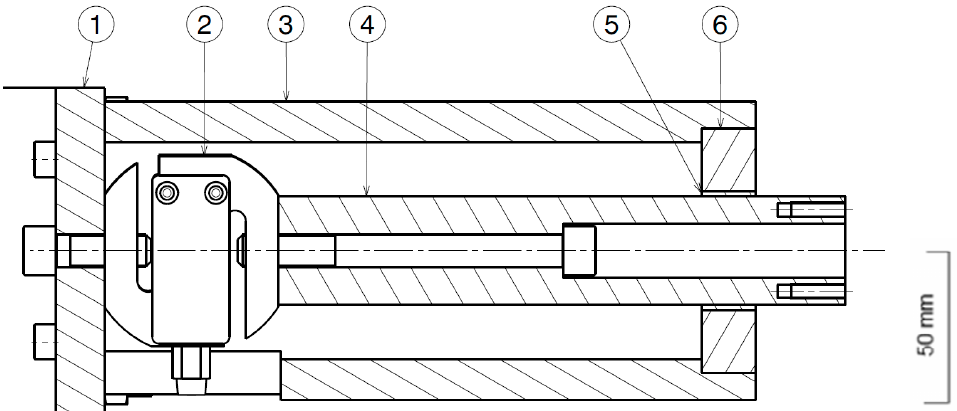
Figure 11. Compression configuration: (1) posterior plate; (2) load cell; (3) outer tube; (4) rod; (5) plain